Question: Produce a descriptive caption suitable for publication.
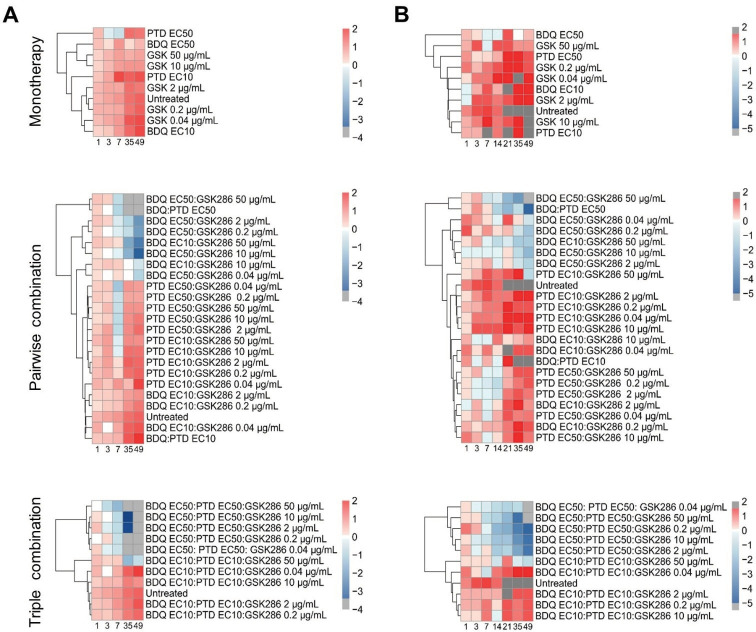
Answer: Combinatorial studies of GSK286 with bedaquiline and pretomanid. Time-kill assay heat map representation of CFU ( A ) and MPN ( B ) counts over 50 days of treatment with GSK286, BDQ, and PTD in monotherapy, pairwise, and triple combination against Mtb H37Rv. Columns represent selected time points (days), and rows represent tested conditions. Cell values represent log 10 CFU/mL relative to the untreated inoculum at day 0. Red indicates growth. Blue shades indicate bacterial burden reduction, with darker shades representing stronger effects. Light gray represents BLQ (CFU < 400 CFU/ml, MPN < 150 MPN/mL) and darker gray ALQ (MPN > 5.5 × 10 8 MPN/mL). CFU, colony-forming unit; MPN, most probable number; BDQ, bedaquiline; PTD, pretomanid; BLQ, below limit of quantification; ALQ, above limit of quantification; EC, effective concentration. EC 10 : 0.103 µg/mL and 0.105 µg/mL and EC 50 : 0.923 µg/mL and 0.948 µg/mL for B and Pa, respectively.